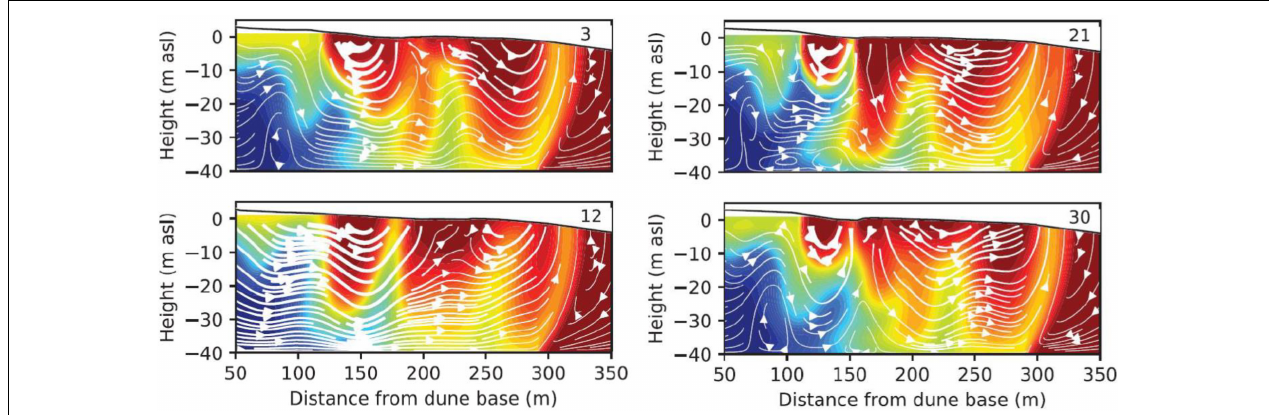
FIGURE 7 | Key findings in the BIME project. Simulated dynamic changes in salinity (red = seawater, blue = freshwater) in the intertidal area of the sandy-beach system on Spiekeroog, and the direction of flow (white arrows), thereby the flow velocity is represented by the thickness of the arrows. The change of the system after 3, 12, 21 months is shown when considering the tide, as well as the change of the topography in the model (modified after Greskowiak and Massmann,